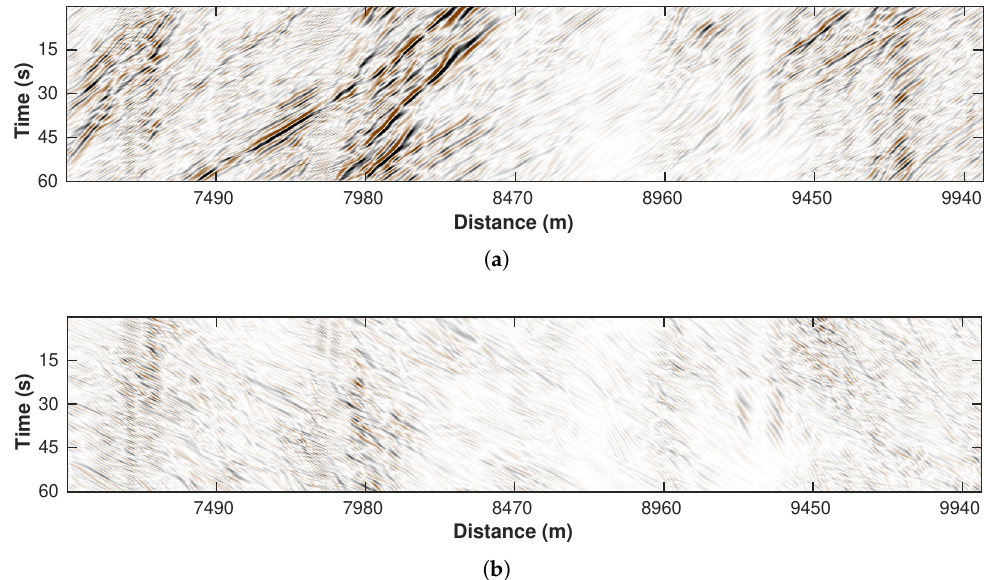
Figure 13. Processing results of dip filtering. ( a ) West-heading traffic signals. ( b ) East-heading traffic signals.